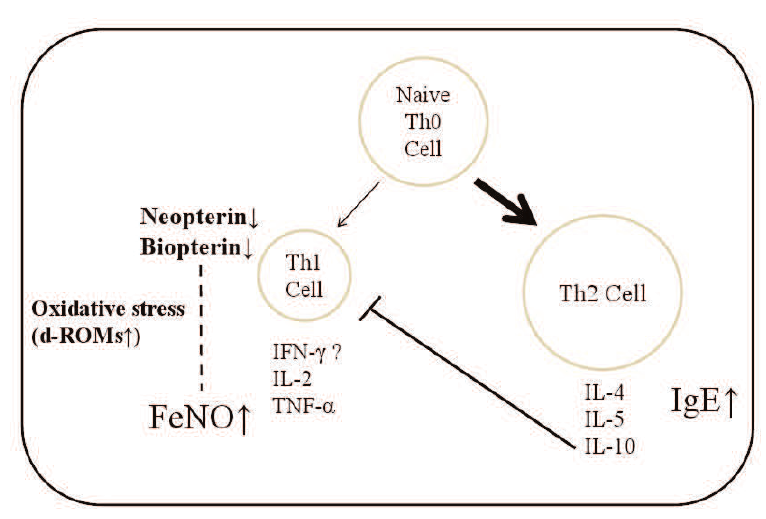
Figure 4.: Proposed mechanisms in relation to immune systems and oxidative stress in asthmatic children: In asthmatic condition, Th2 mediated cytokines may be overproduced including IL10. These cytokines suppress Th1 mediated immune response. As a result, pteridine biosynthesis pathway would not be activated during chronic air- way inflammation. Lower level of neopterin and biopterin causes reactive oxygen species production upon NO